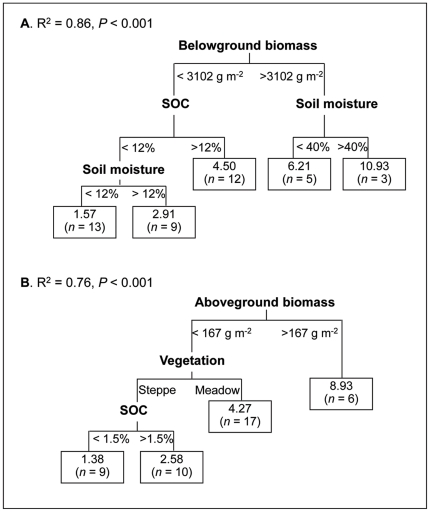
Regression tree showing generalized relationships between daily mean soil respiration rate and environmental variables.Relationships between soil respiration rate and belowground biomass, soil organic carbon content (SOC) and soil moisture (A), aboveground biomass, vegetation type, and SOC (B). Branches are labelled with criteria used to segregate data. Values in terminal nodes represent mean soil respiration rate of sites grouped within the cluster. The tree explained 86% (A) and 76% (B) of the variance in soil respiration rate, which is significantly more than a random tree (P<0.001). n = number of plots in the category.